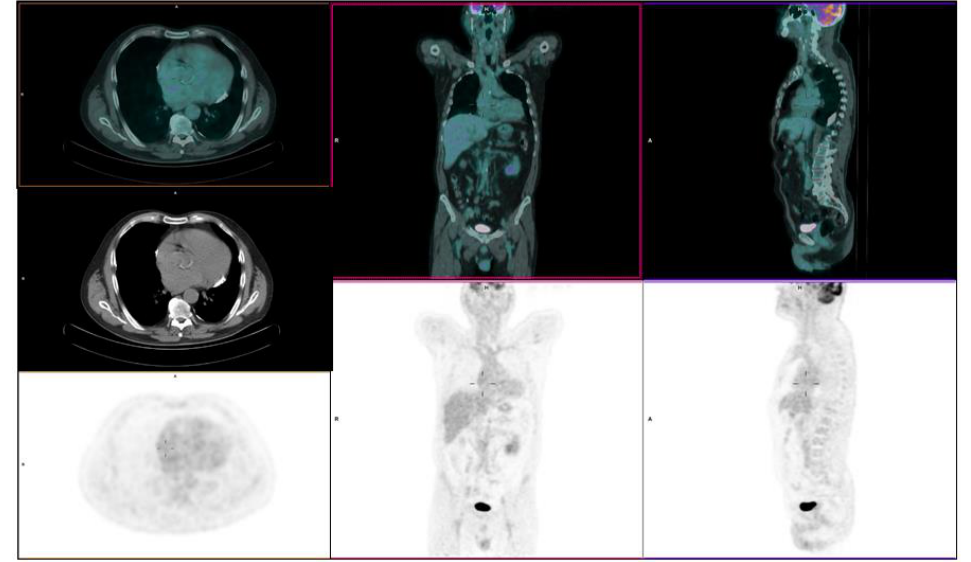
Figure 3. June 2020; 18F-FDG PET / CT after 7 cycles of chemotherapy (R-COMP) showing an early complete response to treatment.